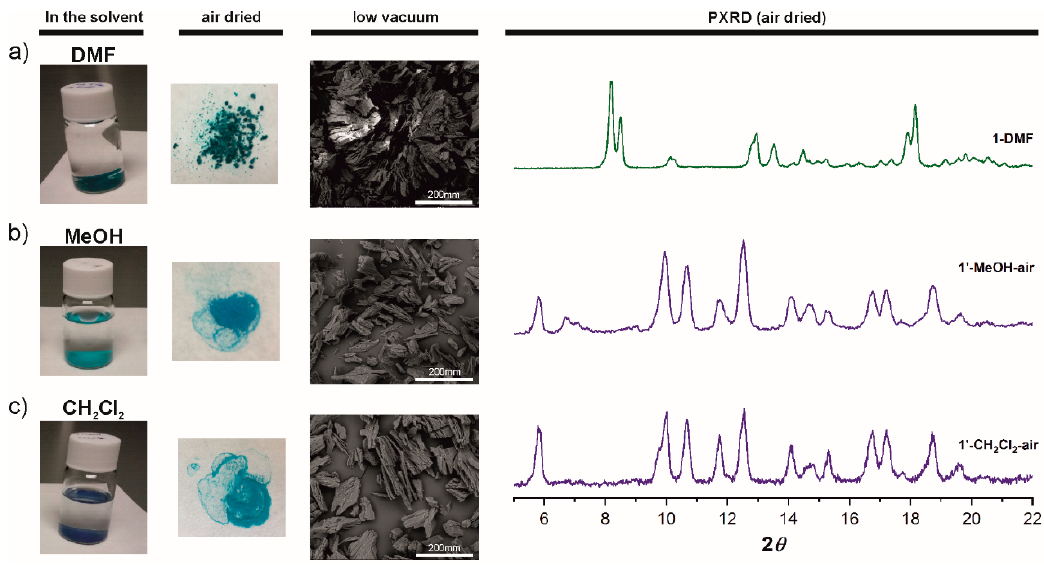
Figure 3. Left: Photographs and SEM images showing crystals color and morphology of as made 1-DMF ( a ), after 2 days in methanol ( b ) and after 2 days in dichloromethane ( c ), in the solvent and after being exposed to air. Right: PXRD patterns for 1-DMF, 1 ′ -MeOH-air, and 1 ′ -CH 2 Cl 2 -air.